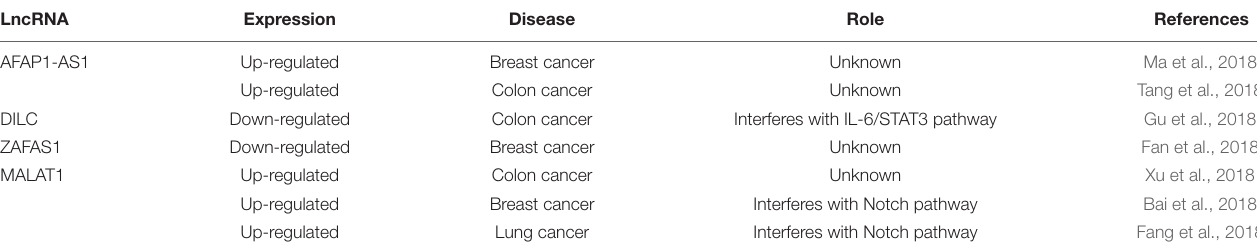
TABLE 1 | Expressions and effects of lncRNAs in most common